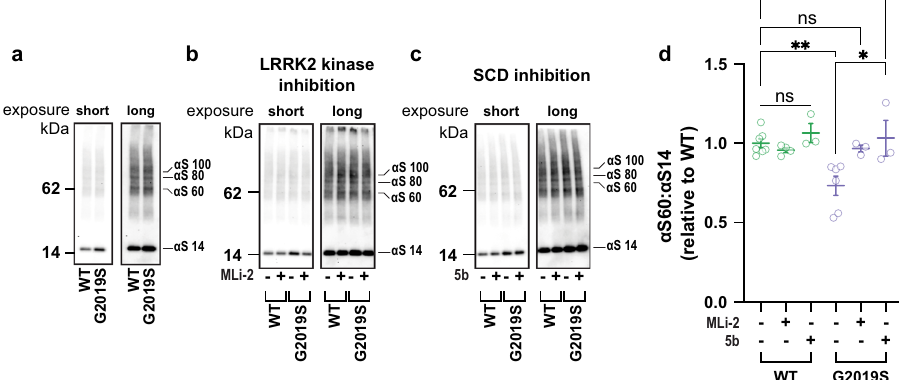
Fig. 7 The G2019S LRRK2 mutation decreases the physiological α Syn T:M ratio in midbrain dopaminergic neurons. Patient-derived iPSCs carrying the G2019S mutation in LRRK2 and its isogenically corrected WT line were differentiated into midbrain DA neurons. a The G2019S mutation reduced the α Syn T:M ratio. Treatment with either a LRRK2 kinase inhibitor ( b ) or an SCD inhibitor ( c ) restored the physiological T:M ratio WT levels ( d ). ( N ≥ 3 independent experiments; each dot is the mean of an independent replicate sample; one-way ANOVA with Tukey ’ s post hoc test; error bars = SEM; * p < 0.05, ** p < 0.01, ns not signi fi